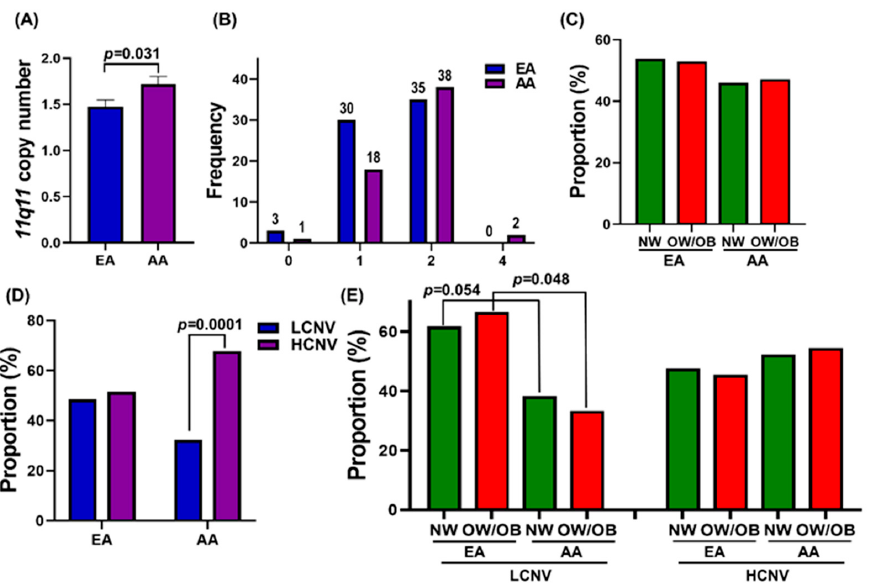
Figure 1. 11q11 copy number in boys and girls. ( A ) The bar graphs represent the mean ± SEM of 11q11 copy number in boy and girl participants. ( B ) Distribution of 11q11 copy number in boys and girls. ( C ) The proportions boys and girls with NW and OW/OB. ( D ) The proportions of low and high CNV in boys and girls. ( E ) The differences in proportions among NW and OW/OB boys and girls, with LCNV and HCNV.